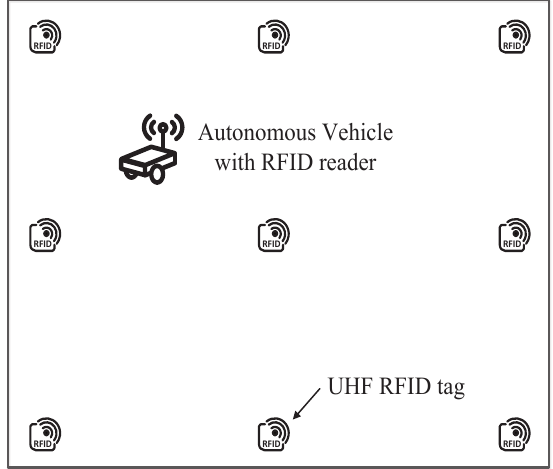
Figure 1. Schematic of the UHF RFID-based indoor autonomous localization and tracking system. The UHF RFID reader is placed on the vehicle, and tags are placed on the